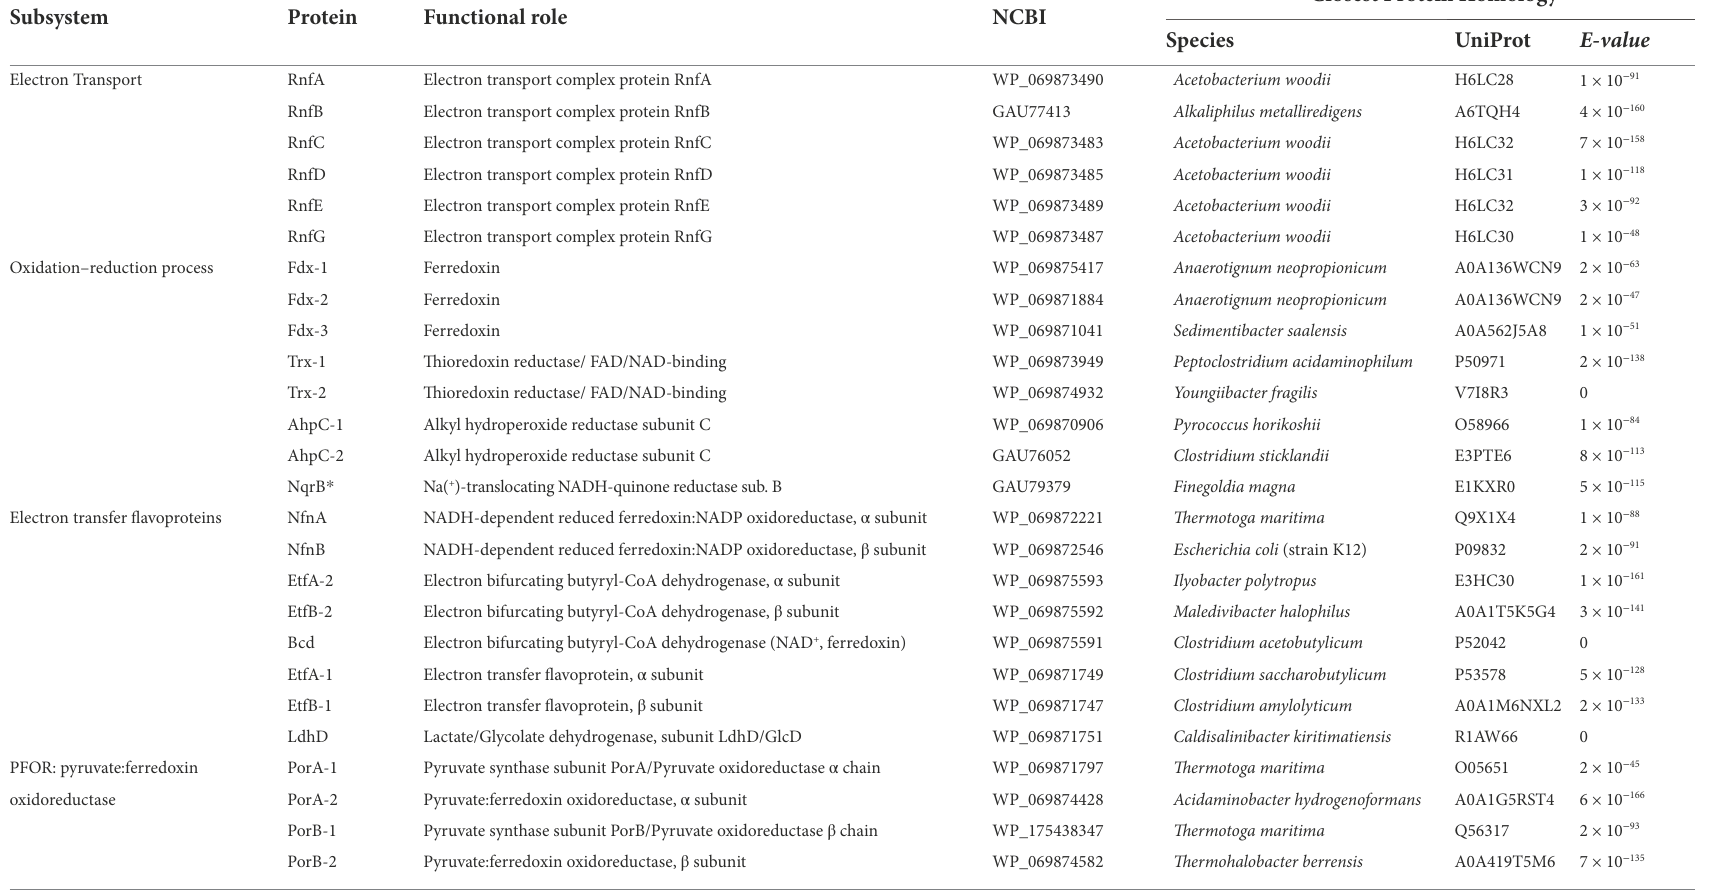
TABLE 3 BLAST results of predicted proteins related to electron bifurcation in Fas